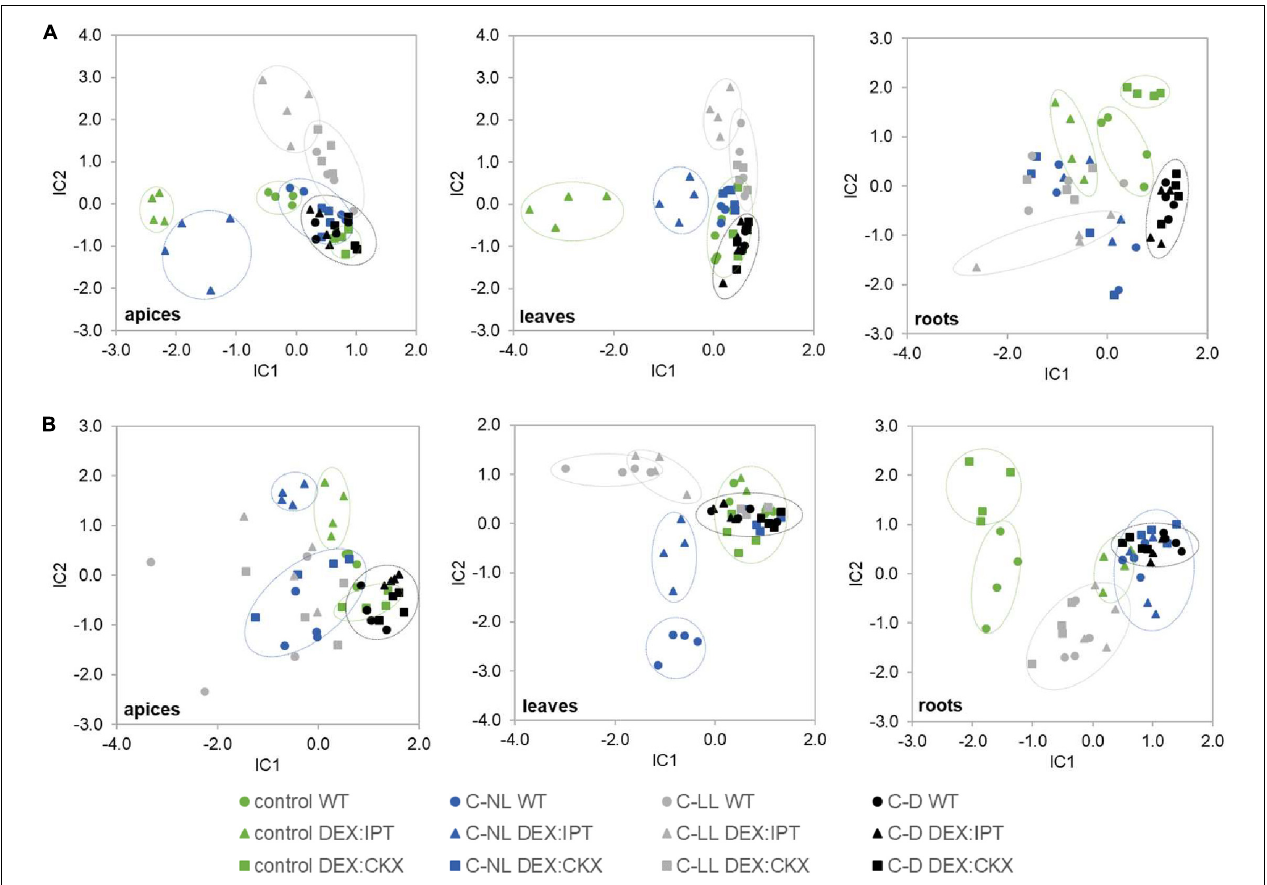
FIGURE 4 | The independent component analysis (ICA) of (A) hormonal and (B) transcriptomic data in apices, leaves, and roots of WT, DEX:IPT , and DEX:CKX plants exposed to cold stress under different light conditions (see Table 1 for the description of variants). All samples are shown as individual points (four biological replicates of each variant). Groups with high diversity are highlighted by circles. In the case of transcriptomic data, the inserted genes were excluded from the